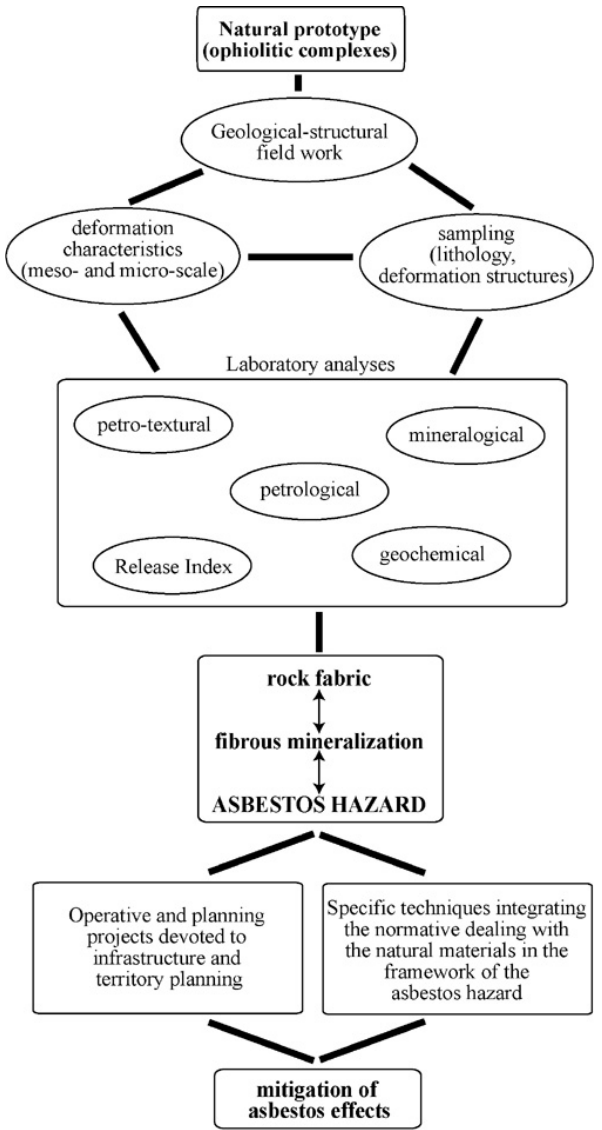
Fig. 8. Flowchart of the proposed multidisciplinary approach cor- relating the geological properties of the ophiolitic rocks to the as- bestos